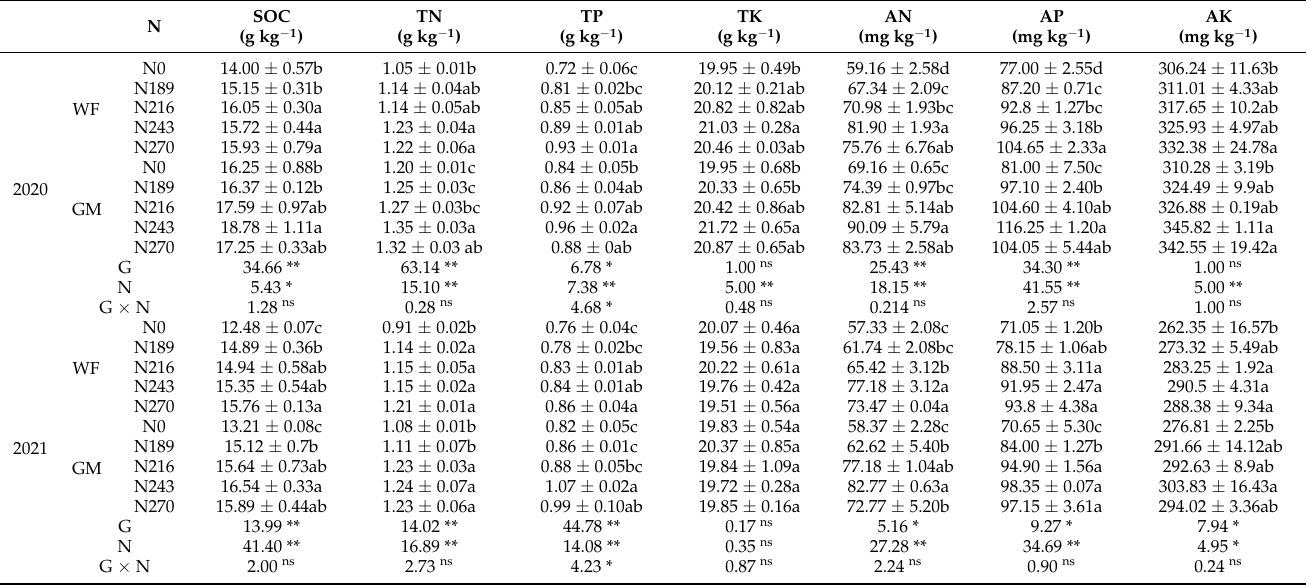
Table 3. The responses of soil chemicals to the application of nitrogen under green manure return strategies in the North China